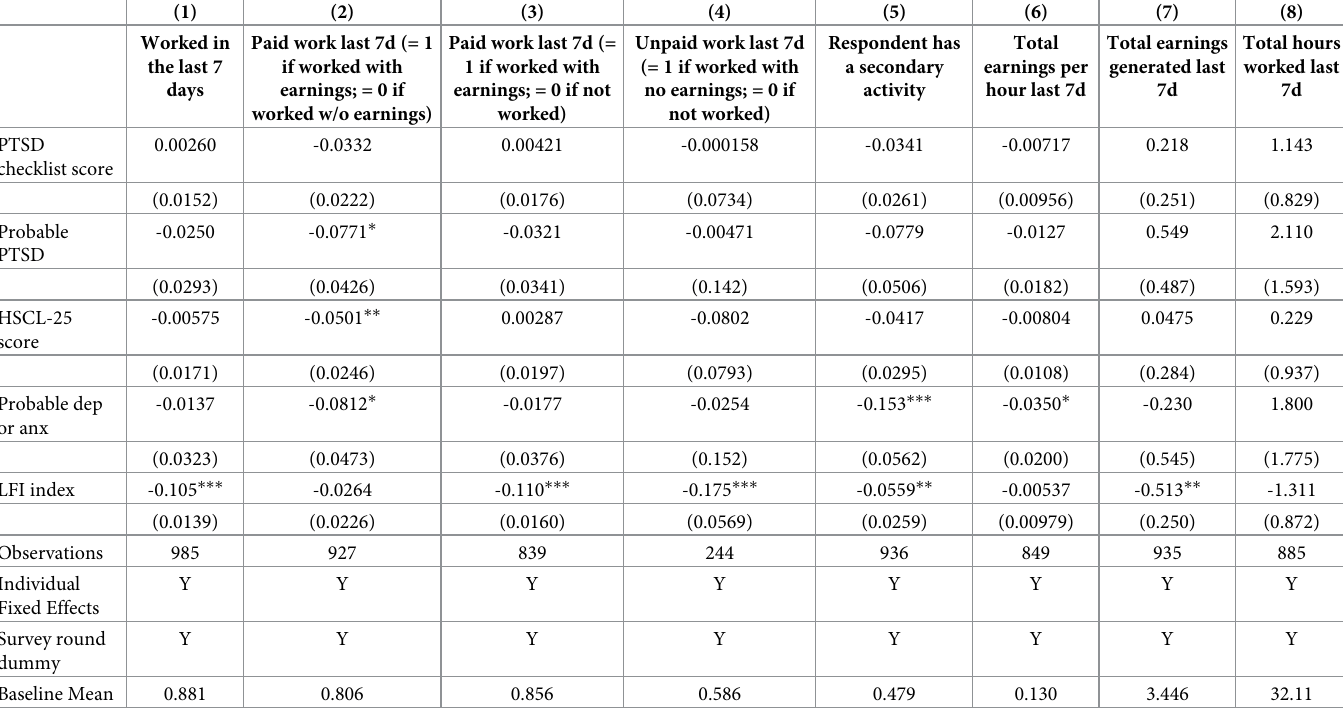
Table 7. Panel regression of women’s work on mental health